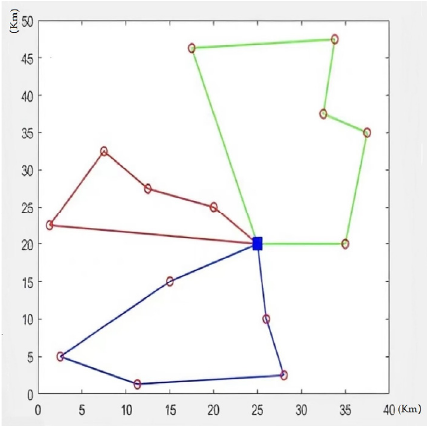
Figure 7. Improved genetic algorithm distribution route.